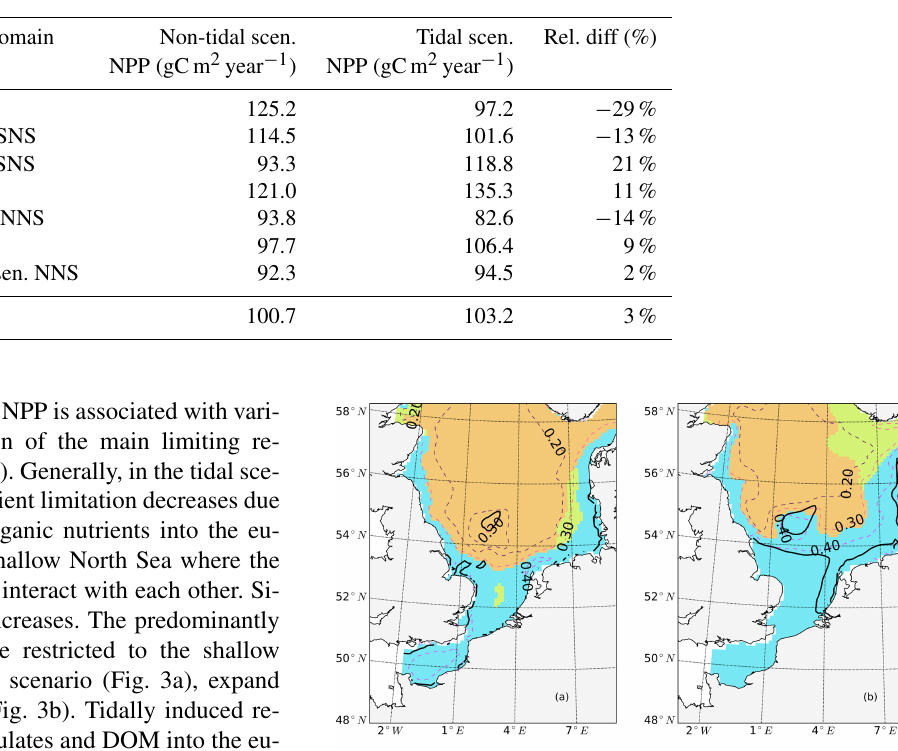
Table 1. Average annual NPP and relative difference between the tidal and non-tidal scenarios in each subdomain and in the entire North Sea.